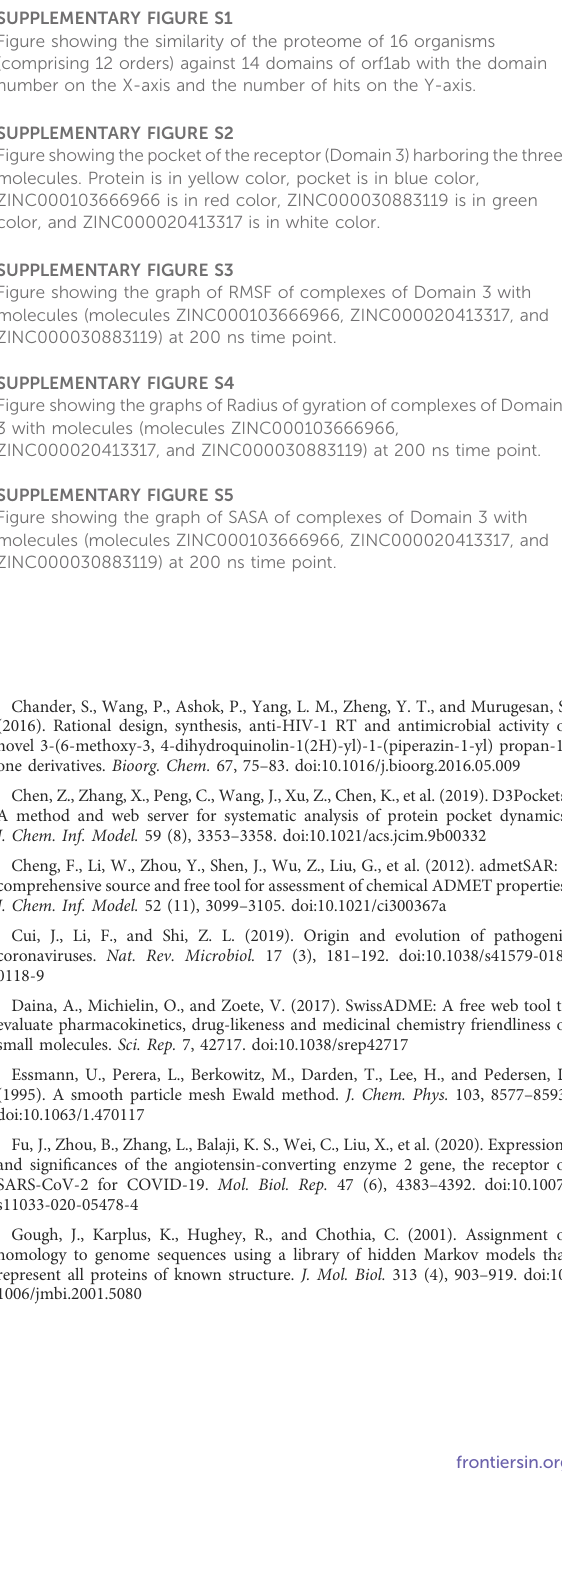
SUPPLEMENTARY FIGURE S1 Figure showing the similarity of the proteome of 16 organisms (comprising 12 orders) against 14 domains of orf1ab with the domain number on the X-axis and the number of hits on the Y-axis. SUPPLEMENTARY FIGURE S2 Figureshowingthepocketofthereceptor(Domain3)harboringthethree molecules. Protein is in yellow color, pocket is in blue color, ZINC000103666966 is in red color, ZINC000030883119 is in green color, and ZINC000020413317 is in white color. SUPPLEMENTARY FIGURE S3 Figure showing the graph of RMSF of complexes of Domain 3 with